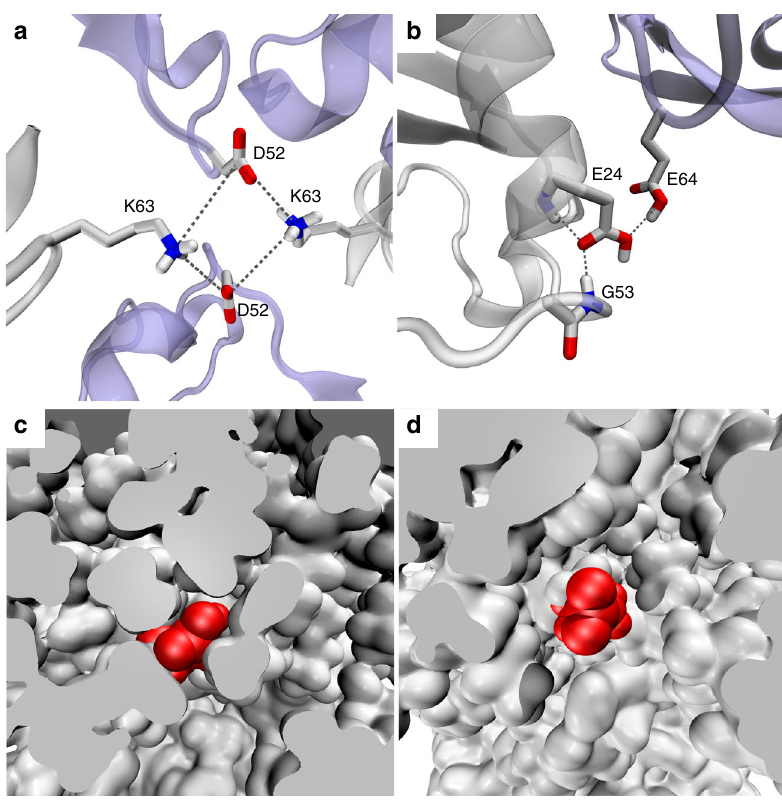
Fig. 4 Intermolecular and intramolecular interactions that affect β -turn motion. a , b Intermolecular interactions involving the β -turn region in MPD-ub. Neighboring molecules are shown in light blue . Simulations of ubiquitin mutants suggest that these interactions are not responsible for causing the preference for β II, see text. c , d The surrounding of E24 side chain in different crystal forms of ubiquitin. c A rare frame from the MPD-ub trajectory where E24 side chain (painted red ) is projected toward solvent. d A typical frame from cubic-PEG-ub trajectory where E24 from ubiquitin molecule chain A is immersed into